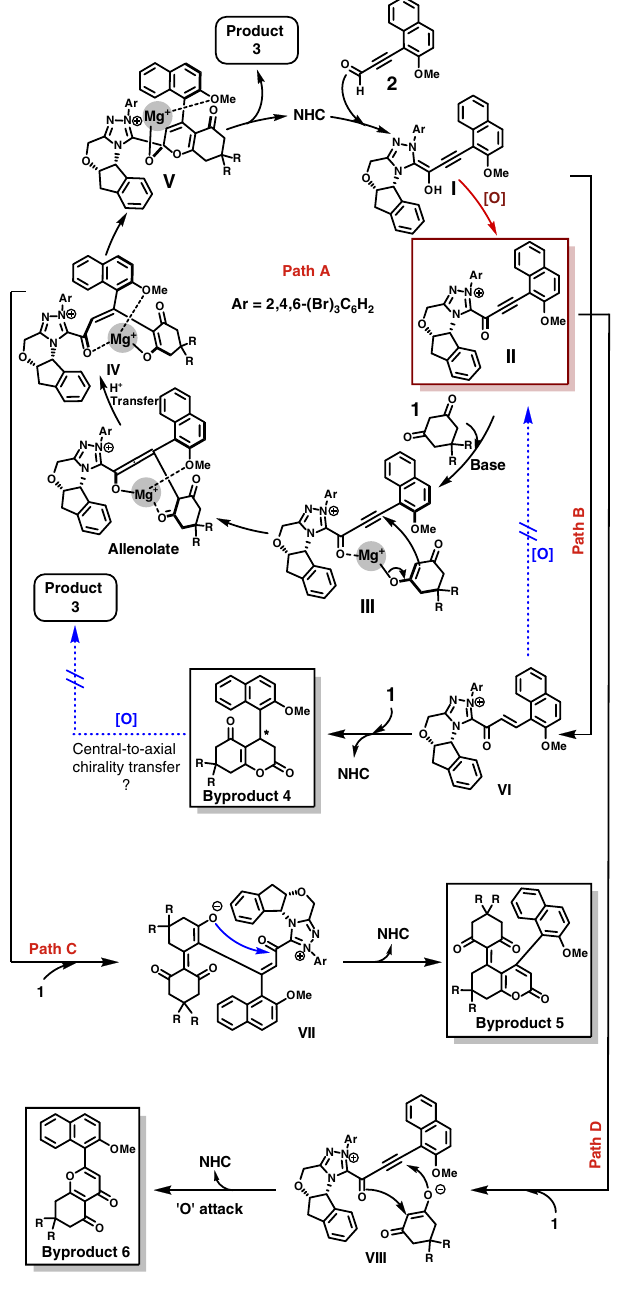
Fig. 6 Postulated mechanistic pathways. Path A shows the formation of product 3 . Path B suggests the formation of byproduct 4 . Path C is a probable way to generate byproduct 5 . Path D indicates a plausible route to explain the formation of byproduct